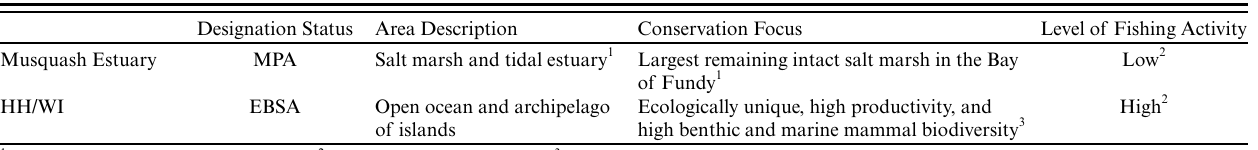
Table 2 . Description of case study locations. EBSA, ecologically and biologically significant area; HH/WI, Head Harbour, West Isles Archipelago, and The Passages; MPA, marine protected area.